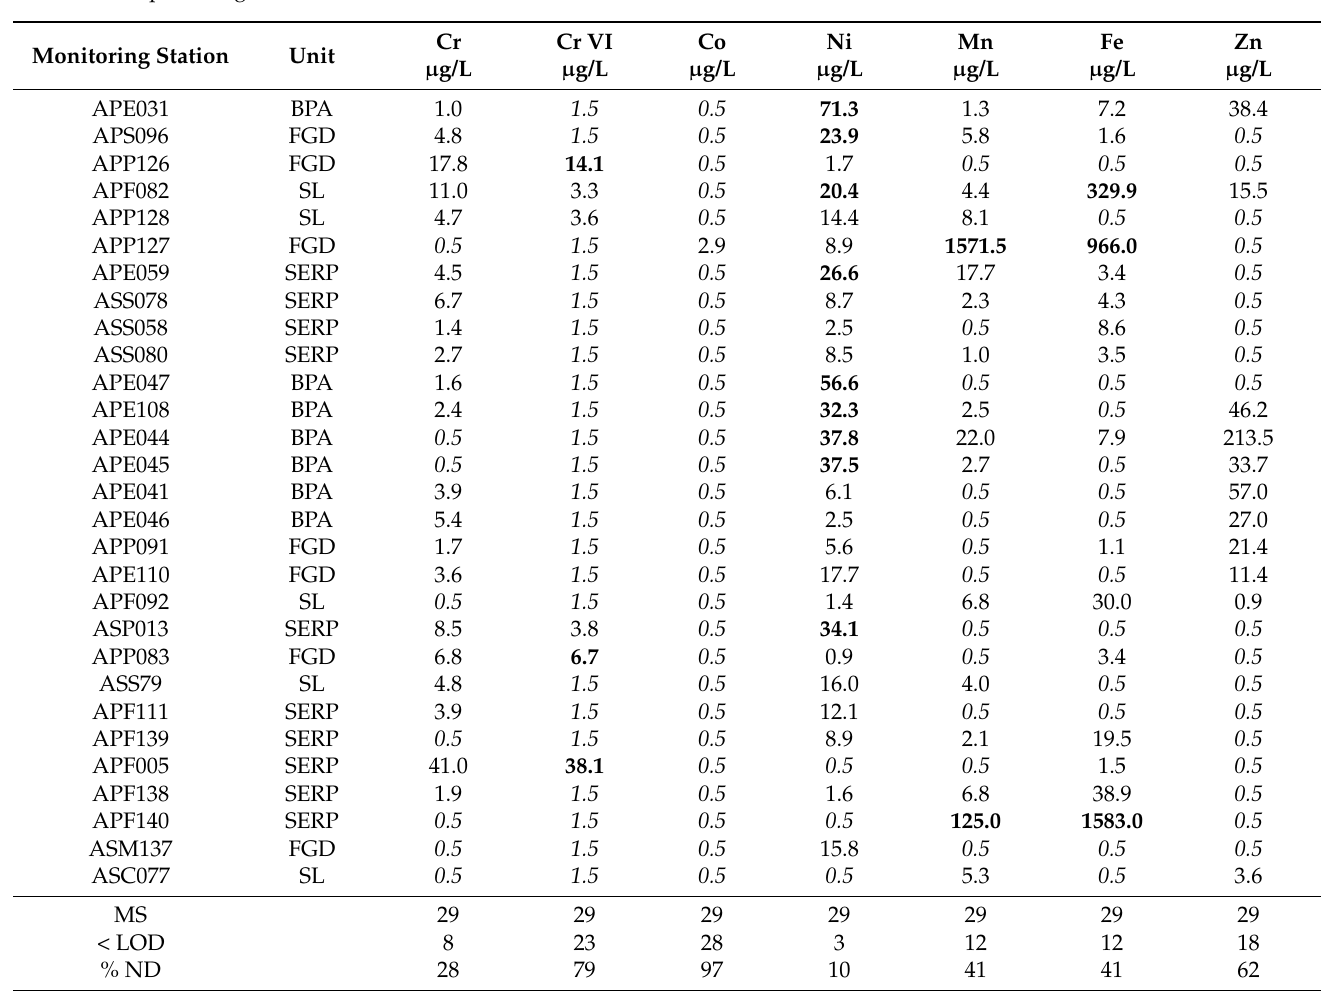
Table 1. Synthesis table reporting the potentially toxic element (PTE) representative values for each monitoring station (MS). Unit: SL = Sesia-Lanzo; SERP = Serpentinite; FGD = Fluvioglacial Deposits; BPA = Balangero Plain Aquifer. Values in italic correspond to those < limit of detection (LOD). Values in bold exceed the threshold values (TVs) for water quality [15]. % ND = percentage of non-detected